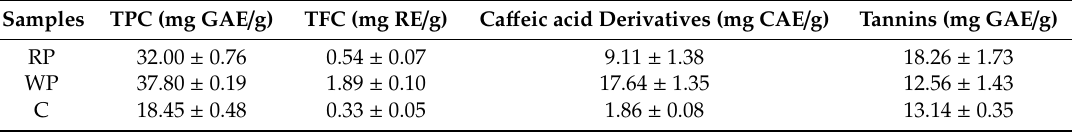
Table 3. Total polyphenol content of studied